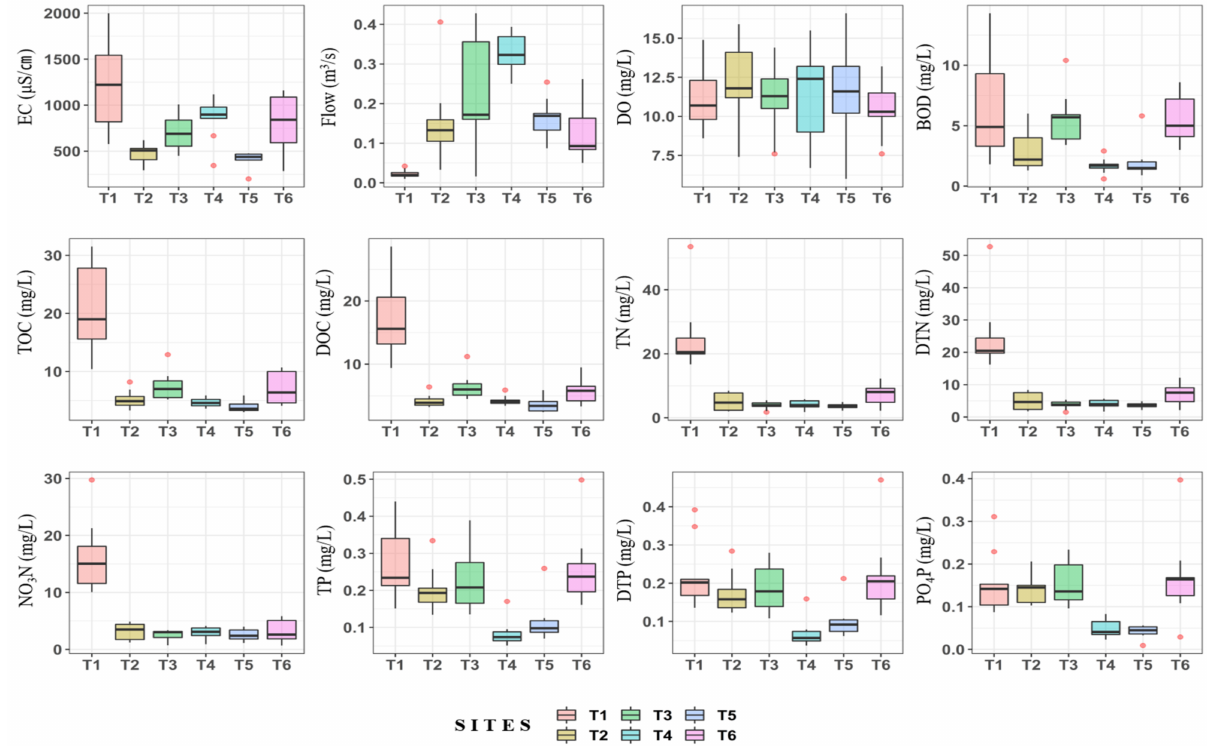
Figure 3. Comparison of field data (EC, flowrate, and DO), organic matter parameters (BOD, TOC, and DOC), and nutrient data (TN, NO 3 N, DTN, TP, DTP, and PO 4 P) for the six major tributaries of the Miho upstream